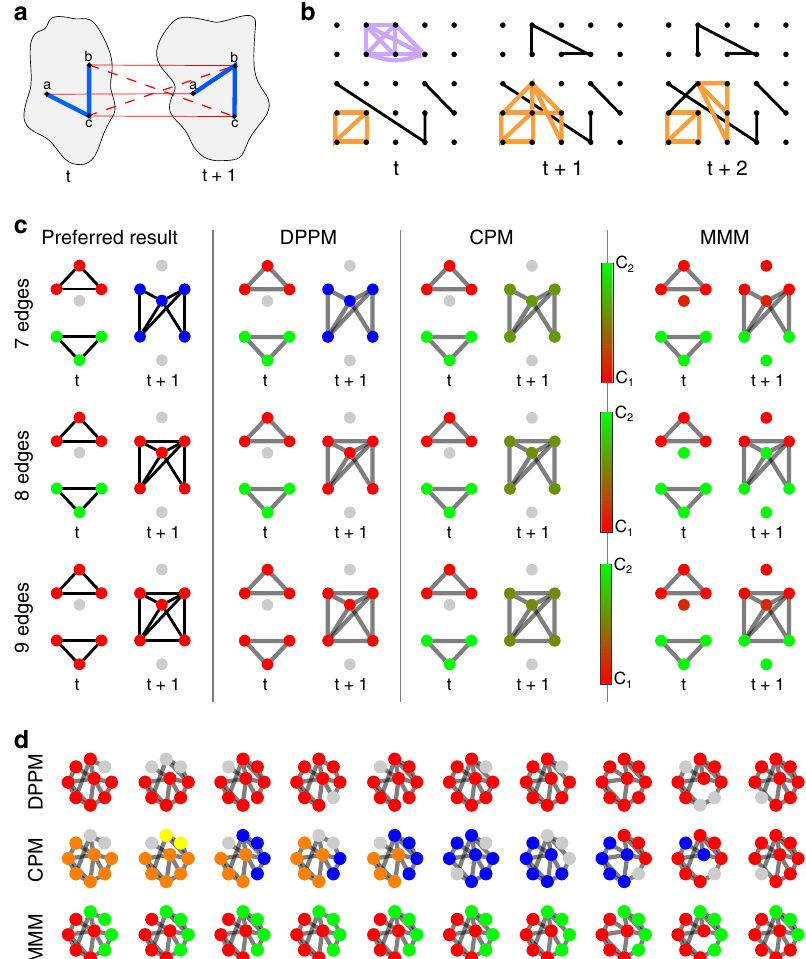
Fig. 1 Illustration of DPPM principles and effectiveness. a Schematic of the bridges used to walk plexes within dynamic communities across time. Blue edges represent inferred connectivity, while red edges connecting the same (solid) or adjacent (dotted) vertices facilitate movement. b Illustrative example showing how a simple community (in orange) is tracked by DPPM across time in a manner allowing for both coalescence and fragmentation. This community at fi rst grows at t + 1, and then fragments at t + 2. Another community present at t (purple) perishes at t + 1. c Comparison of DPPM (with 2- plex of size m = 3, 2nd column), CPM (with 1-plex of size m = 3, 3rd column), and MMM (with γ = 1, ω = 1, 4th column) in determining communities across two adjacent time points t and t + 1. The connected component at time t + 1 shares increasingly more edges components at time t from the top to the bottom row of plots. In the preferred results, the dynamic communities (1st column) depend on the number of edges shared from time t to t + 1. Whereas DPPM treats these as three distinct scenarios, neither CPM nor (effectively) MMM distinguish the three cases. In CPM and MMM, the colorbar indicates the proportion of community membership over n = 100 repetitions of community detection. d Example dynamic community tracking in the presence of missing edges. Dynamic community membership for ten example sequential time index networks computed using DPPM (with 2-plex of size m = 4), CPM (with 1-plex of size m = 3), and MMM (with γ = 1, ω = 1). While DPPM detects a single dynamic community in time, the other two methods do